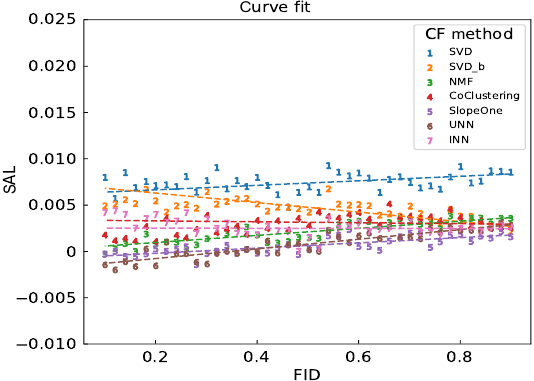
Fig. 6 SAL versus FID using P 1 at constant FUD =0.7.